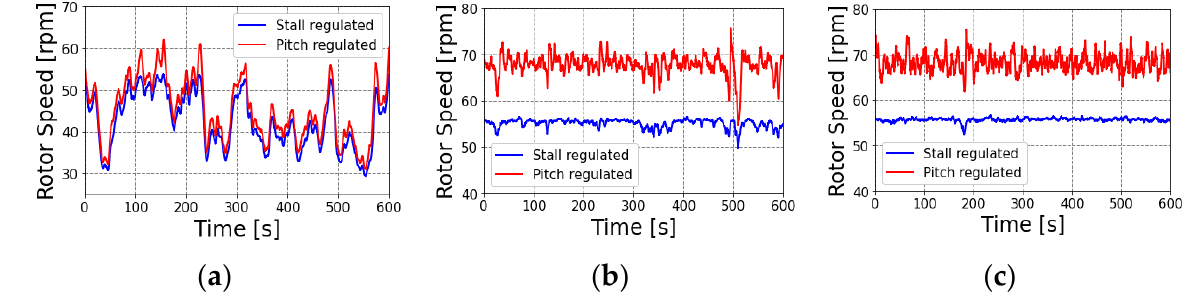
Figure 16. Generator speed for a ( a ) 7 m/s average wind speed simulation, ( b ) a 12 m/s average wind speed simulation, and ( c ) a 16 m/s average wind speed simulation. Results for the same simulations shown in Figure 15.